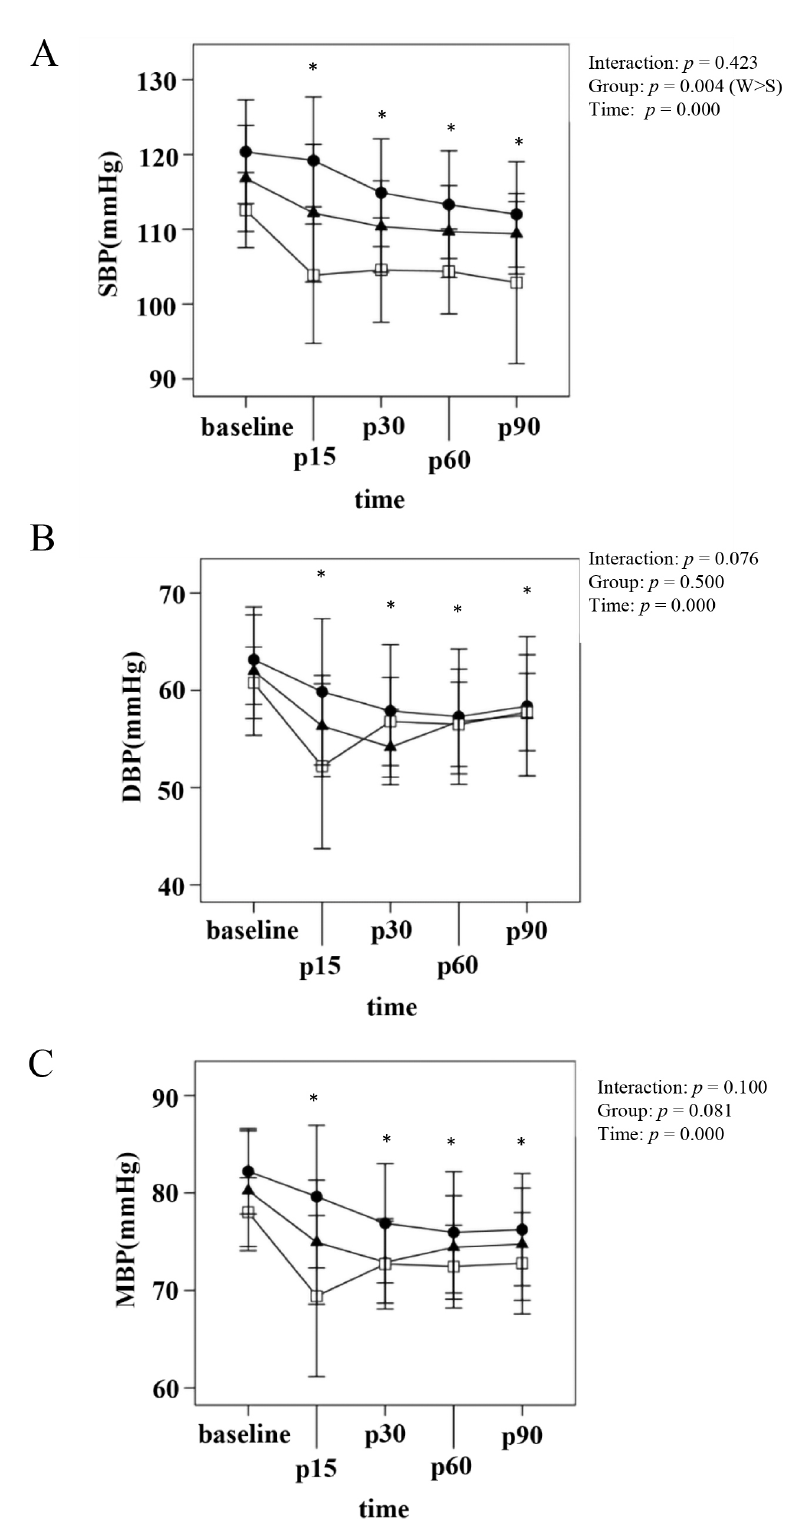
Fig. 1. Blood pressure before and after exercise. Data are presented as means ± standard deviations. □ , Sedentary controls (S); • , Weightlifters (W); and ▲ , Runners. * p < 0.05 compared with baseline. p15, p30, p60, and p90; 15, 30, 60, and 90 min after exercise, respectively. SBP, systolic blood pressure; DBP, diastolic blood pressure; MBP, mean blood